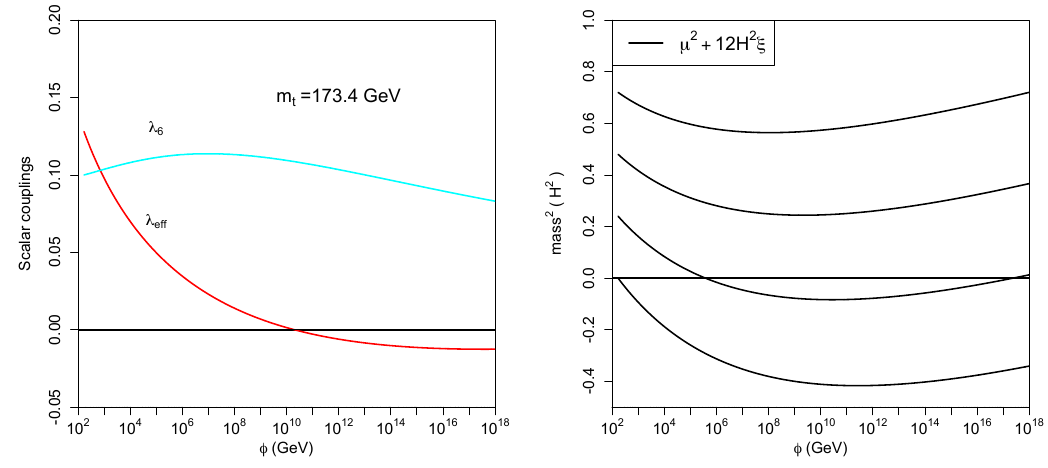
Figure 1 . On the left, running couplings (cid:21) and (cid:21) 6 with m t = 173 : 4GeV. On the right is the e(cid:11)ective mass squared (cid:22) 2 = (cid:22) 2 + 12 H 2 (cid:24) . The initial conditions are (cid:21) (170GeV) = 0 : 128, e(cid:11) (cid:21) 6 (170GeV) = 0 : 1 and (cid:22) 2 (170GeV) = 0.